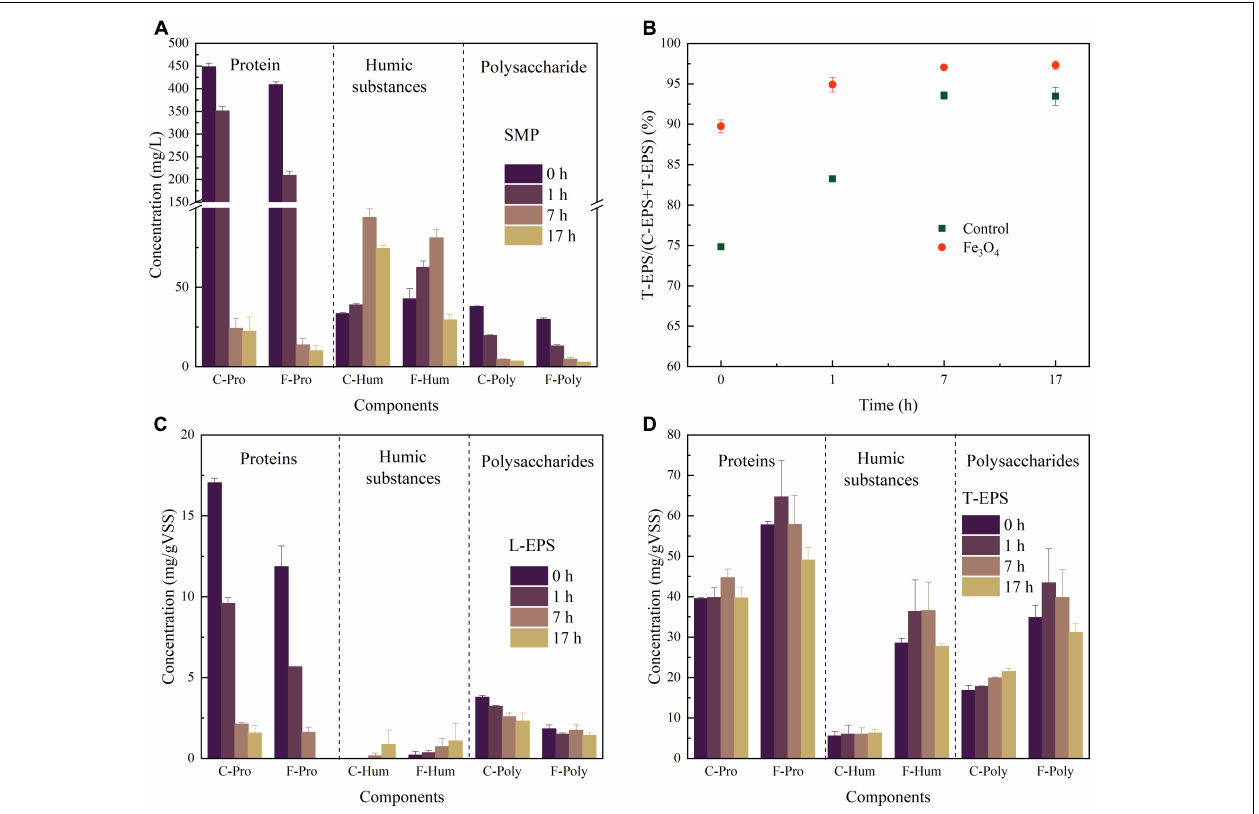
FIGURE 2 | (A) Components of SMP, (B) the ratio of T-EPS and T-EPS+L-EPS, (C) components of L-EPS, and (D) components of T-EPS at different time in the control and Fe 3 O 4